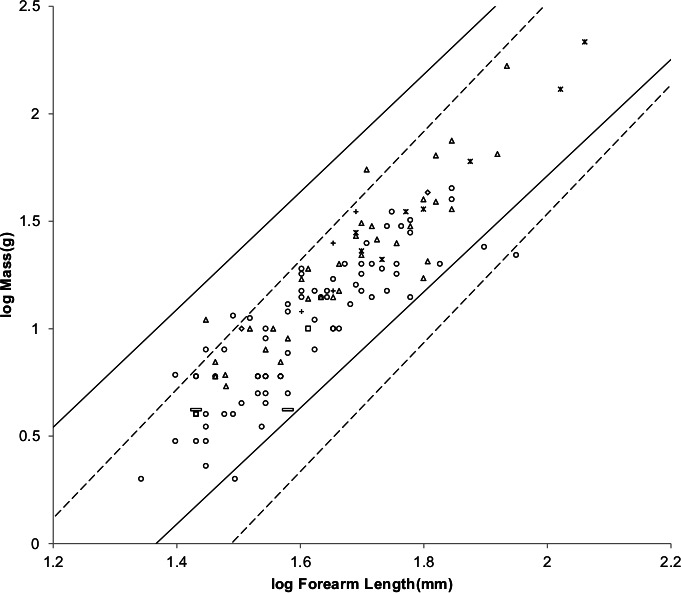
Log body mass as a function of log forearm length for intermediate bats.The solid and dashed lines are the MMLE sturdiness factor boundaries. The upper boundaries were generated with a sturdiness factor s = (3)0.5. The lower boundaries were generated with s = (3)−0.5. The shallower sloping solid boundary lines are for heavy bat Strouhal dynamic similarity. The steeper sloping dashed boundary lines are for geometric similarity. \documentclass[12pt]{minimal}
\usepackage{amsmath}
\usepackage{wasysym}
\usepackage{amsfonts}
\usepackage{amssymb}
\usepackage{amsbsy}
\usepackage{upgreek}
\usepackage{mathrsfs}
\setlength{\oddsidemargin}{-69pt}
\begin{document}
}{}${R}_{M}^{2}=0.998$\end{document}RM2=0.998 for intermediate bats with respect to the Strouhal boundaries. \documentclass[12pt]{minimal}
\usepackage{amsmath}
\usepackage{wasysym}
\usepackage{amsfonts}
\usepackage{amssymb}
\usepackage{amsbsy}
\usepackage{upgreek}
\usepackage{mathrsfs}
\setlength{\oddsidemargin}{-69pt}
\begin{document}
}{}${R}_{M}^{2}=0.9981$\end{document}RM2=0.9981 for intermediate bats with respect to the geometric boundaries. \documentclass[12pt]{minimal}
\usepackage{amsmath}
\usepackage{wasysym}
\usepackage{amsfonts}
\usepackage{amssymb}
\usepackage{amsbsy}
\usepackage{upgreek}
\usepackage{mathrsfs}
\setlength{\oddsidemargin}{-69pt}
\begin{document}
}{}${R}_{M}^{2}=0.9999$\end{document}RM2=0.9999 for intermediate bats with respect to both sets of boundaries.